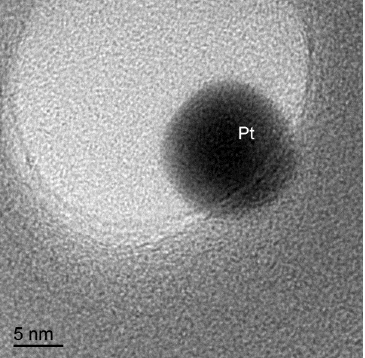
Figure 2. TEM ((Transmission Electronic Microscopy) image of a Pt nanoparticle infiltrated in the catalyst ‐ electrode.